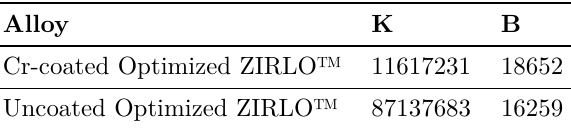
Table 2. K ( mg.dm − 2 .min − 1 / 2 ) and B (K) values for coated and uncoated cladding materials from Eq. 4 for air oxidation.